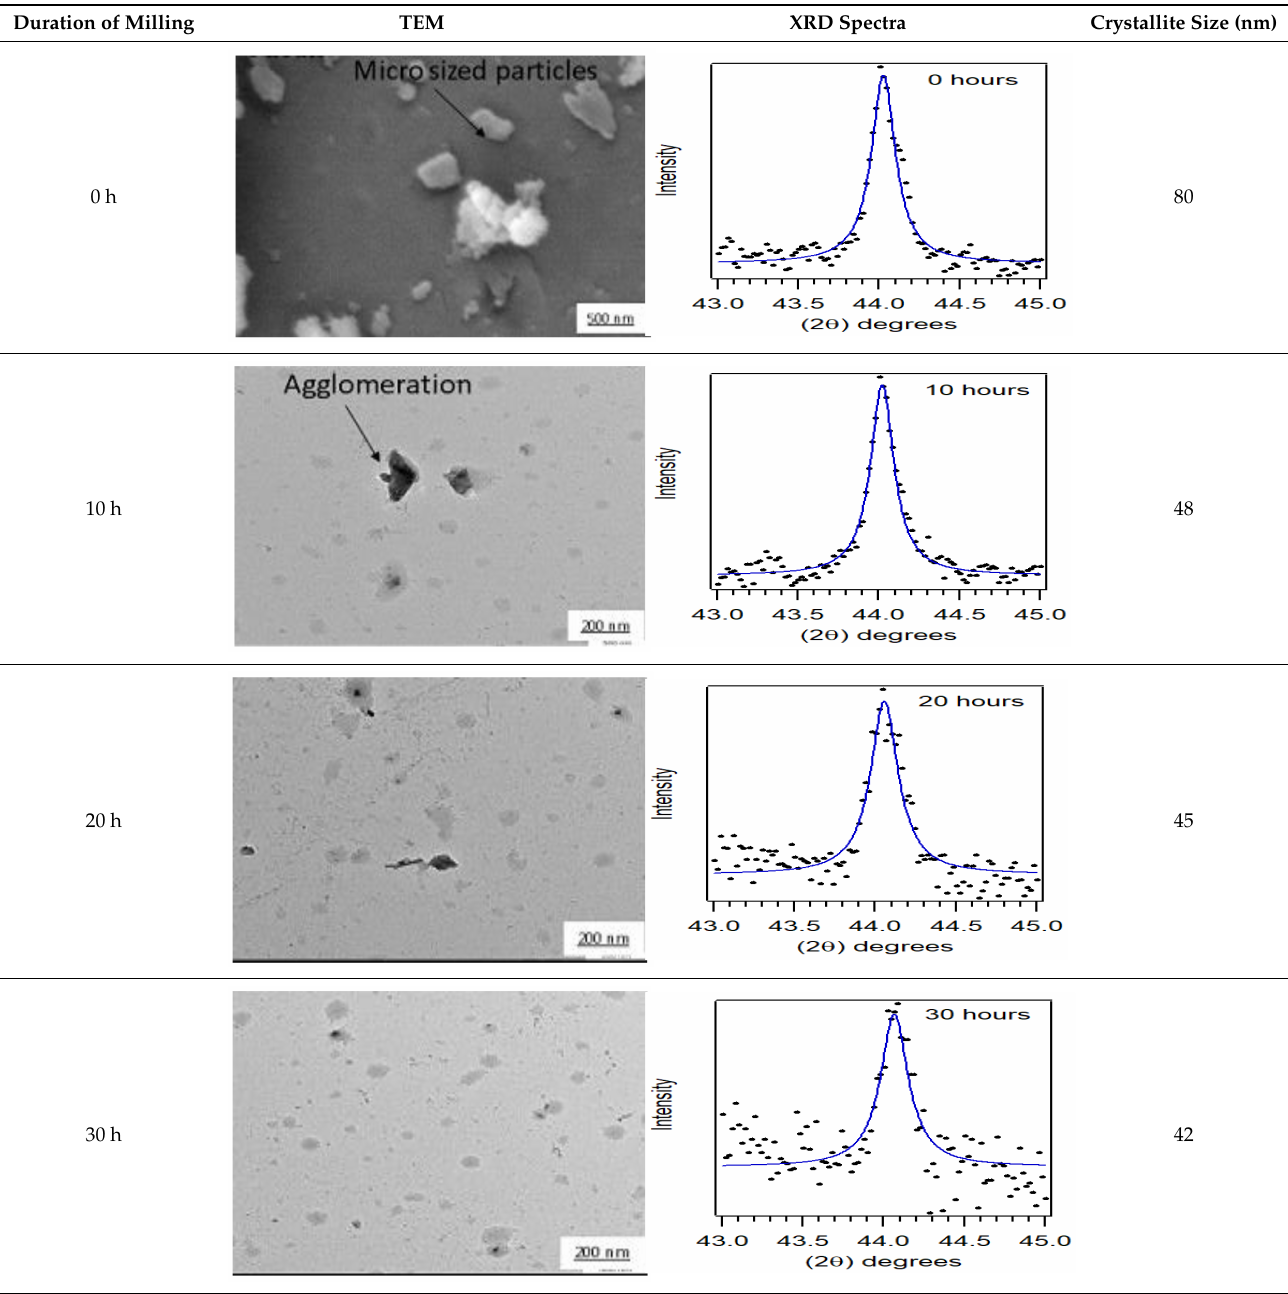
Table 5. Crystallite size of coconut shell